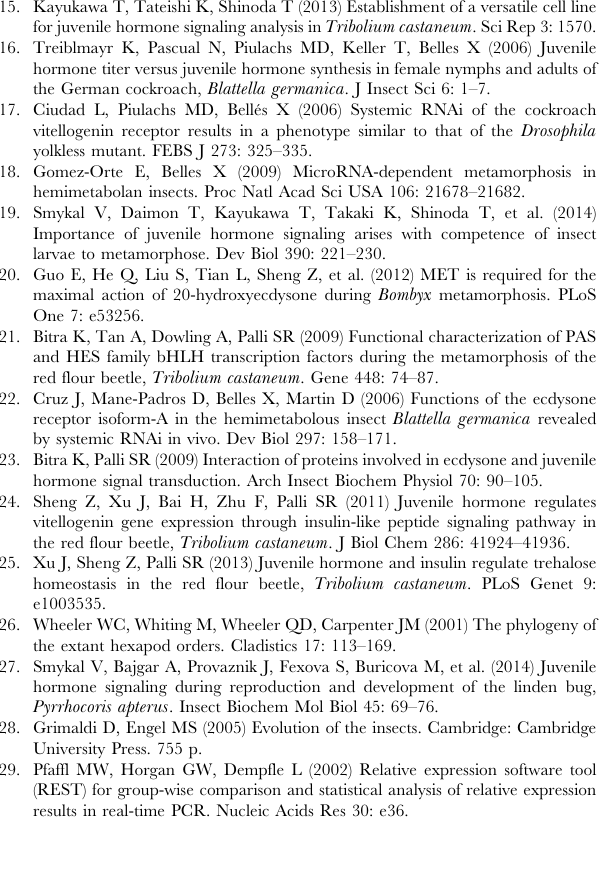
(REST) for group-wise comparison and statistical analysis of relative expression results in real-time PCR. Nucleic Acids Res 30: